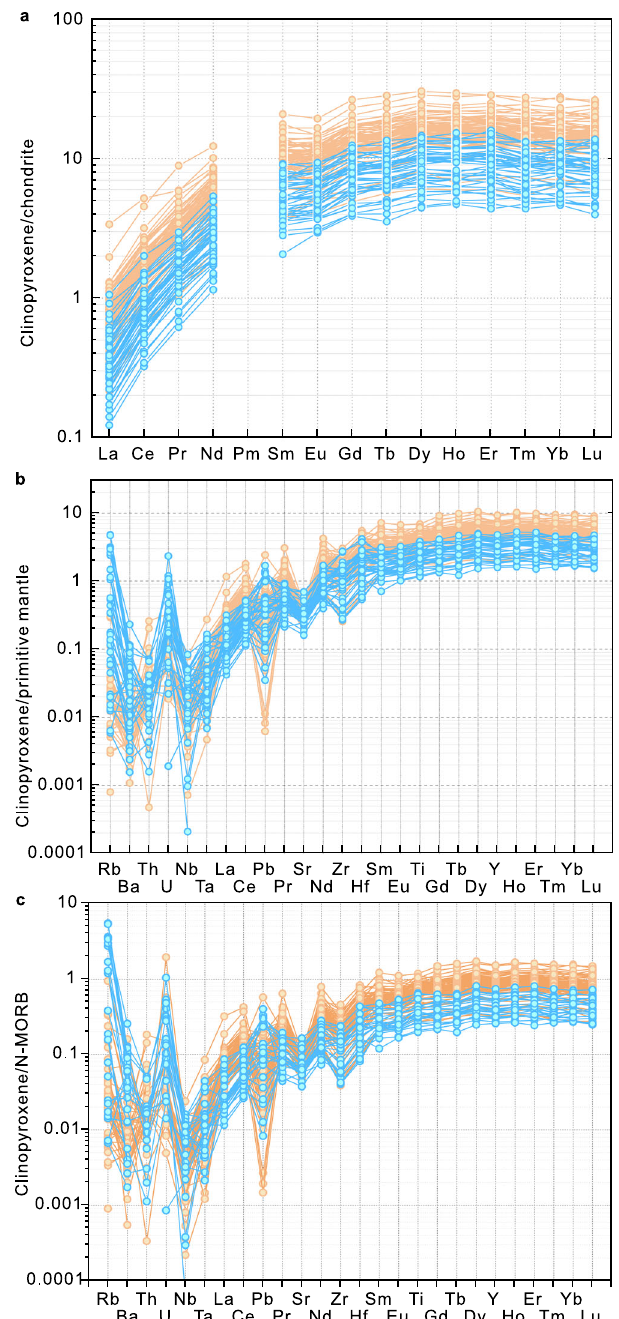
normalized 47 rare earth element abundances for clinopyroxene in subunits 1c and 1e of ASB basalts. b Primitive mantle-normalized 47 trace element abundances for clinopyroxene in subunits 1c and 1e. c N-MORB- normalized 47 trace element abundances for clinopyroxene in subunits 1c and 1e. N-MORB represents normal mid-ocean ridge basalt. Yellow circles are data for subunit 1c and blue-green circles for subunit